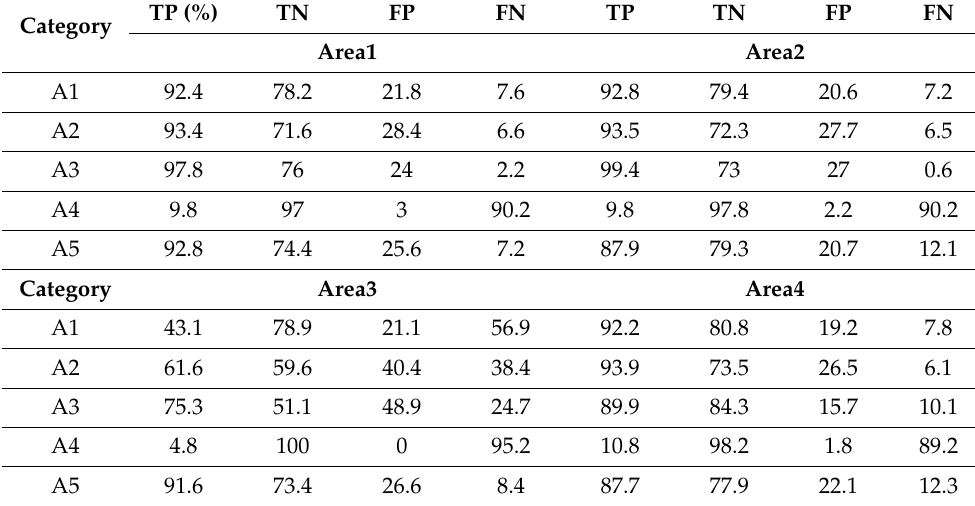
Table 10. The performance measurements True Positive (TP), True Negative (TN), False Positive (FP), and False Negative (FN) associated with the highest accuracies achieved using selected features in A category for all four AOIs as highlighted in Table 8.